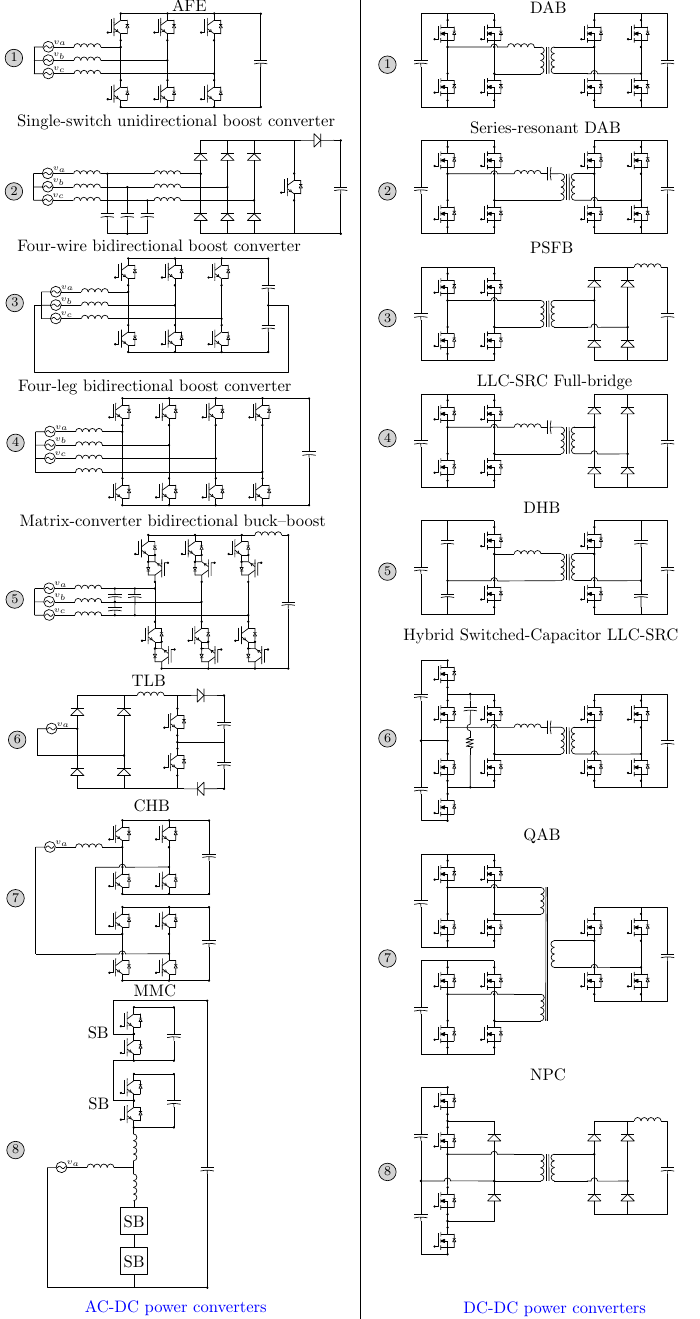
Figure 10. Some of the possible power electronic converters that can be used in a DC SST-based ultra-fast charging